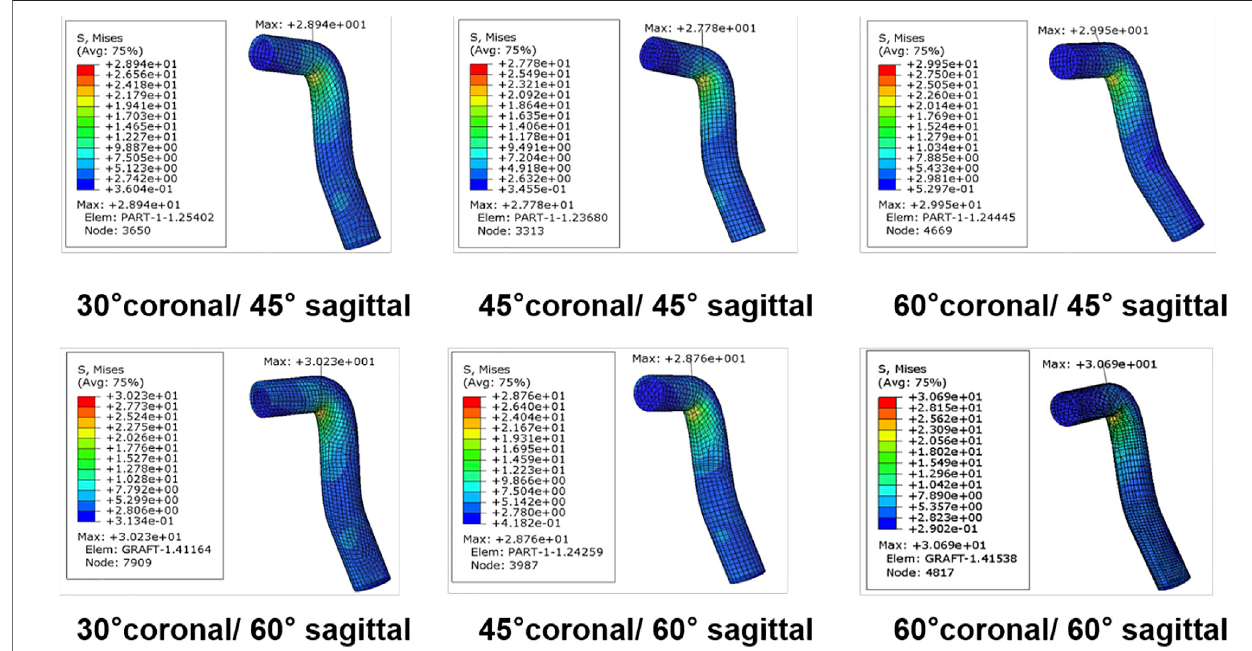
FIGURE 8 | Stress distribution around the ACL graft following